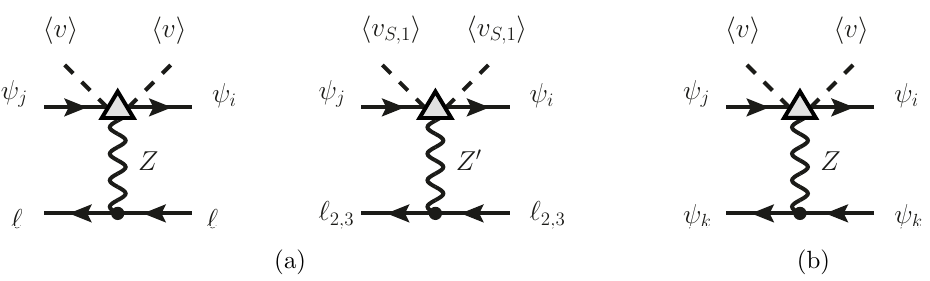
Figure 4. Flavour-changing (cid:1) F = 1 processes that are mediated in the G ( 0 ) -EFTs by dimension SM six 2 ’ 2 D -operators (indicated by the triangle), which are in turn generated at the scale (cid:22) M at tree level. Semileptonic transitions j ! Z 0 exchange, depending on the model. Not shown are analogous